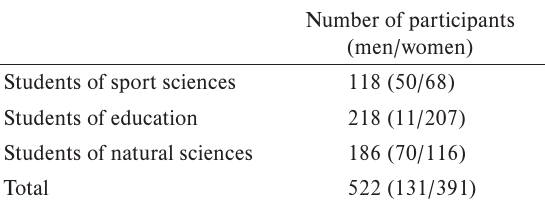
Characteristics of study participants (N = 522) Number of